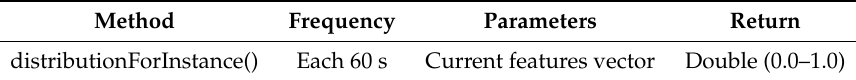
Table 4. Configuration parameters to evaluate the Isolation Forest